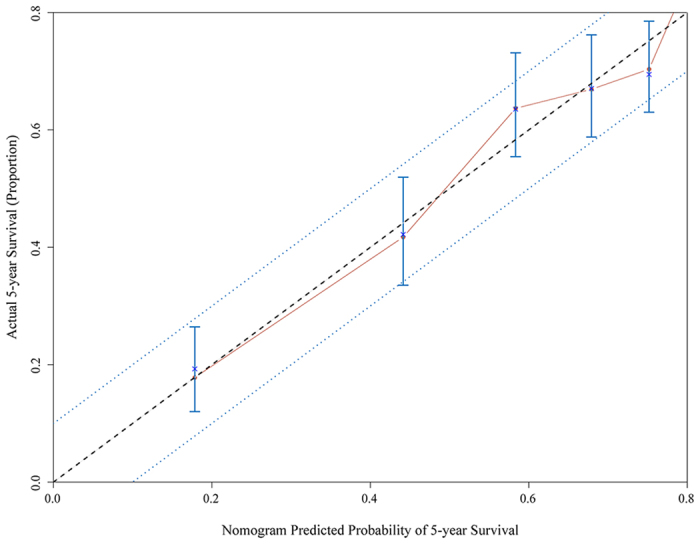
Calibration of the nomogram predicted system.Nomogram predicted probability of overall survival was plotted on the x-axis, actual overall survival was plotted on the y-axis and 95% CIs measured by Kaplan-Meier analysis. All predictions lie within the 10% margin of error (within the blue dots line).